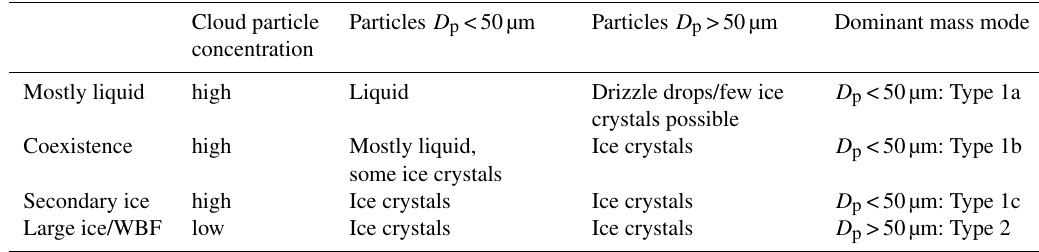
Table 1. Characteristics of the cloud types expected in the mpt regime.